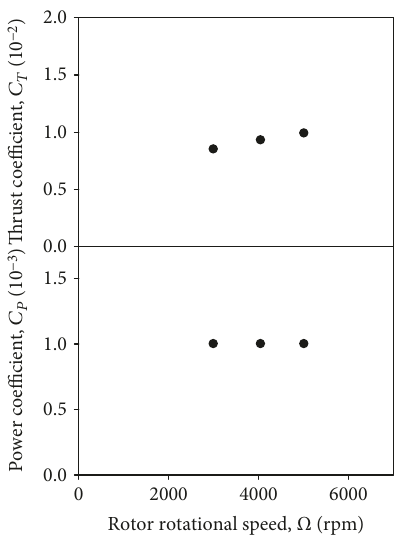
Figure 8: Thrust and power coe ffi cients for T-motor 18x6.1 in a static